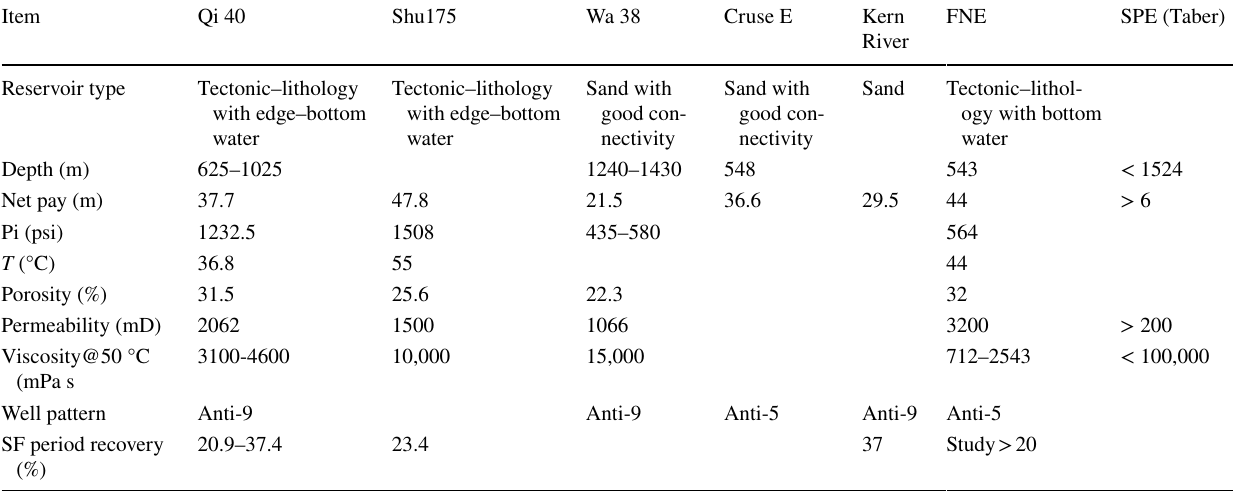
Table 1 Reservoir properties of each oil field using steam flooding (Elbaloula et al. 2016; Pearce and Megginson 1991; Jones et al. 1995; Taber et al. 1997)